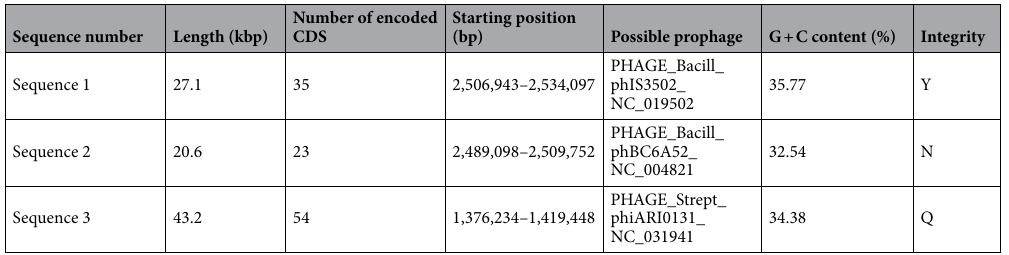
Table 7. The pro-phage sequences in the chromosome DNA of strain HS18-1. Y: complete; N: incomplete; Q: unknown.